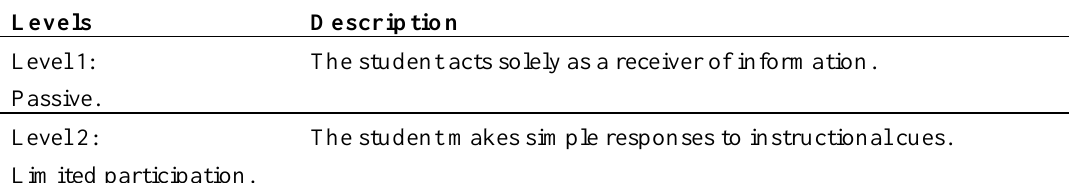
Interactivity Levels and